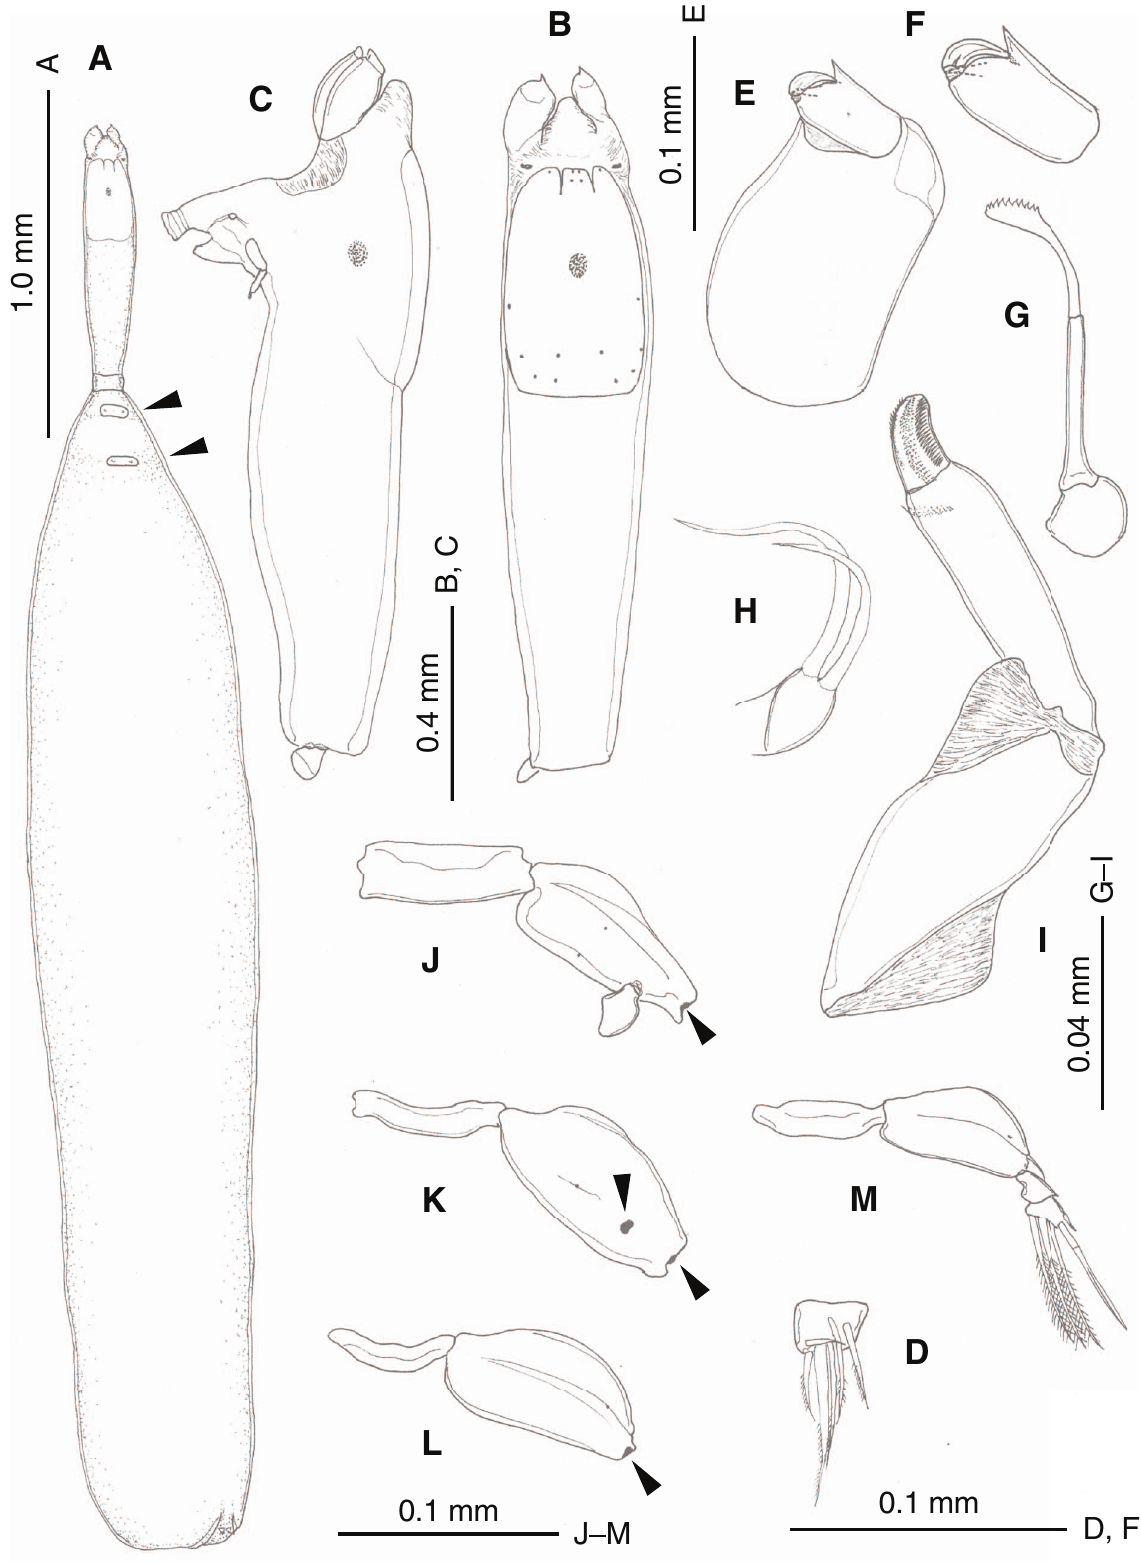
Figure 2. Peniculus hokutoae n. sp., holotype female. (A) Habitus, dorsal view, posterior part twisted, tergites on third and fourth pedigerous somites arrowed; (B) Cephalothorax, dorsal view; (C) Cephalothorax, lateral view; (D) Caudal ramus; (E) Antenna; (F) Terminal segment of antenna; (G) Mandible; (H) Maxillule; (I) Maxilla; (J) Leg 1, anterior view; (K) Leg 2, anterodistal view; (L) Leg 3, anterior view; (M) Leg 4, anterior view. Arrows in (J) to (L) indicate bases of